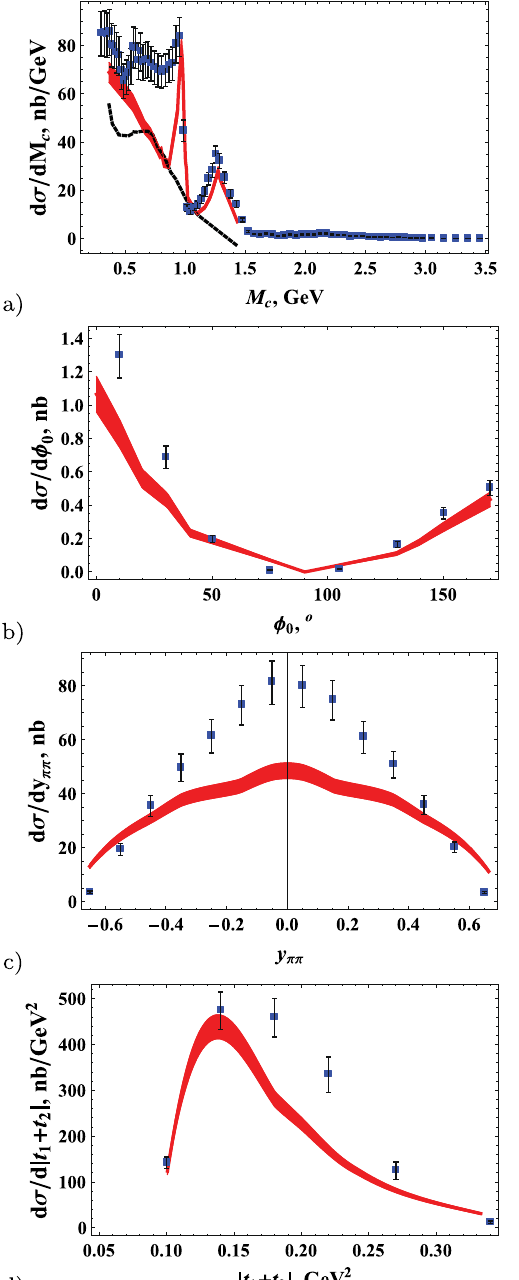
Fig. 8 The new preliminary data on the process p + p → p + π + + √ π − + p at s = 510 GeV (STAR collaboration [26]): | η π | < 0 . 7, √ p T π > 0 . 2 GeV, p x > − 0 . 27 GeV, 0 . 4 GeV < | p y | < 0 . 8 GeV, ( p x + s = 0 . 6GeV ) 2 + p 2 y < 1 . 25 GeV 2 , where p denotes the momenta of final protons. The theoretical solid curve corresponds to Λ π = 1 . 2 GeV in theoff-shellpionformfactor(11)andcouplingsfrom(14).Fluctuations are due to a complex Monte Carlo integration process, and they can be smoothed by increasing the integration